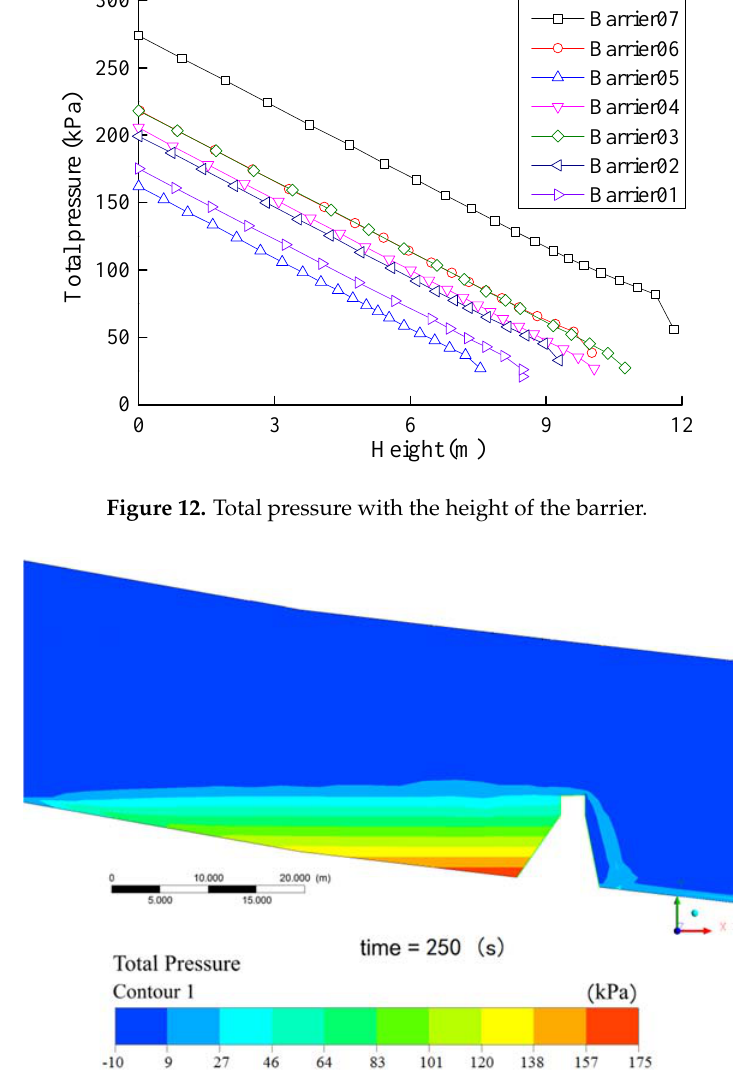
Figure 13. Total pressure distribution on Barrier 01.